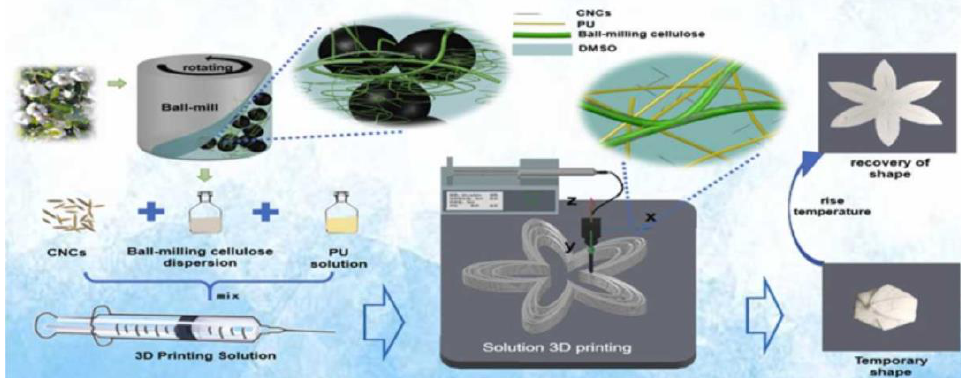
Figure 26. Diagram illustrates the 3DP of the shape memory nanocellulose/polyurethane composites [258]. Table 4. The shape fixation rate and shape recovery rate of the 3D-printed PU/nanocellulose shape memory composites compared with the pure PU (table reproduced from [258]).